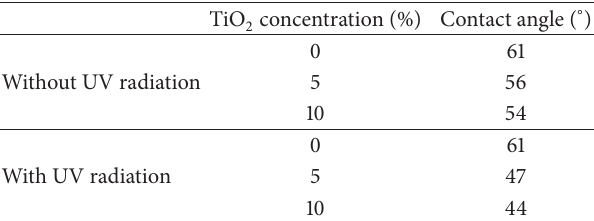
Table 2: Contact angle between deion water drop and the surface of the PES